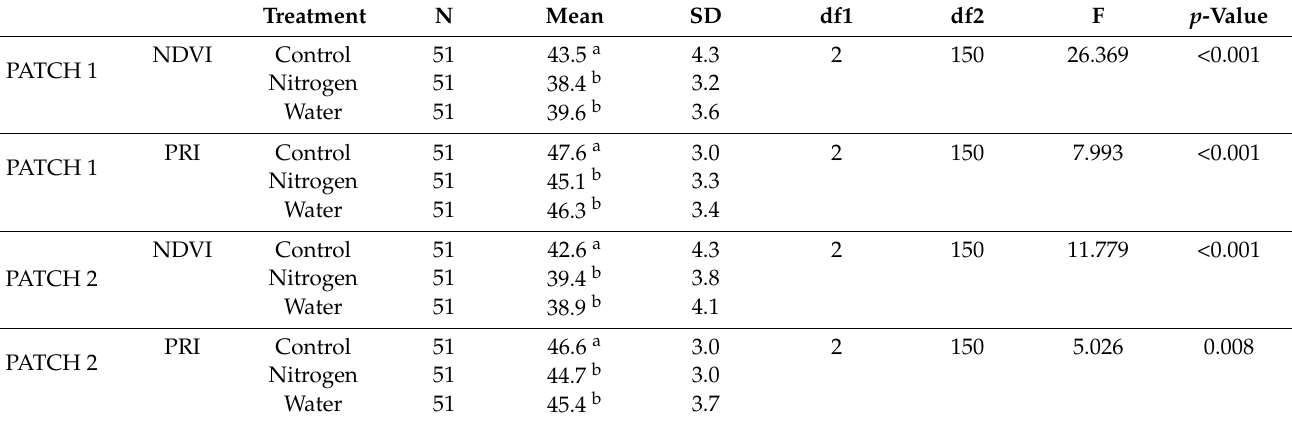
Table 3. Results of the statistical analysis of grayscale multispectral imaging comparing the quantita- tive mean values of the three treatments (Control, Nitrogen, and Water). The columns represent the sample size (N), mean value (Mean), standard deviation (SD), and degrees of freedom between the groups (df1) and within the groups (df2), F-test (F), and level of significance ( p -value). The letters (‘ a ’ and ‘ b ’) indicate significant differences in energy consumption between the two treatments at a significance level of p <